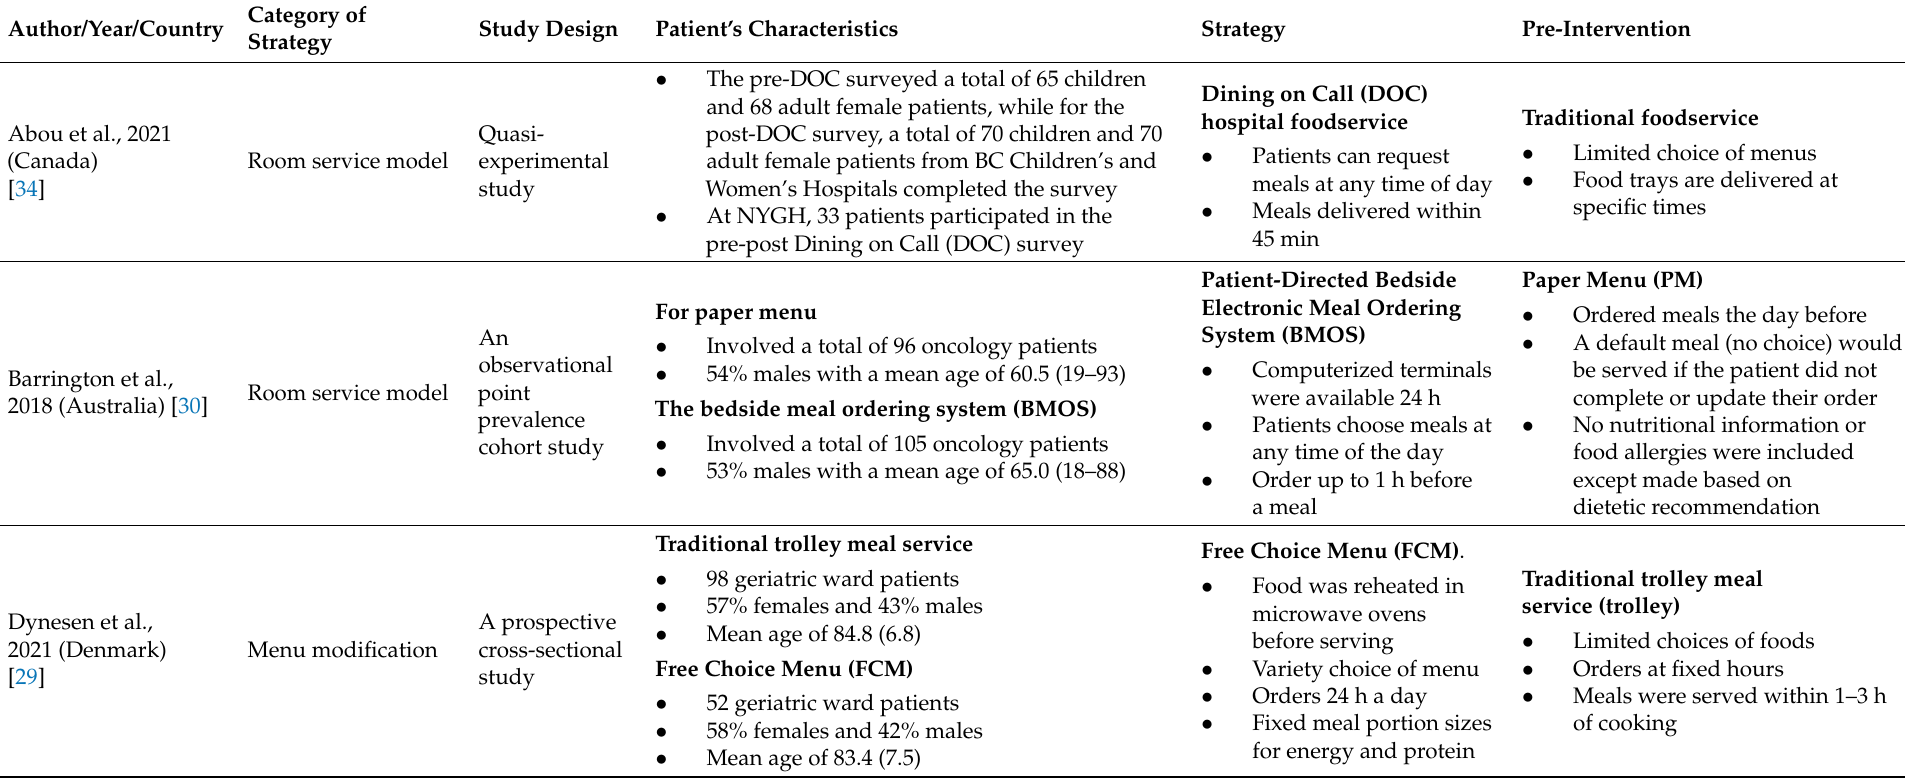
Table 2. Summary of strategies implemented as pre-interventions and interventions to reduce the rate of plate waste in hospitals and the characteristics of